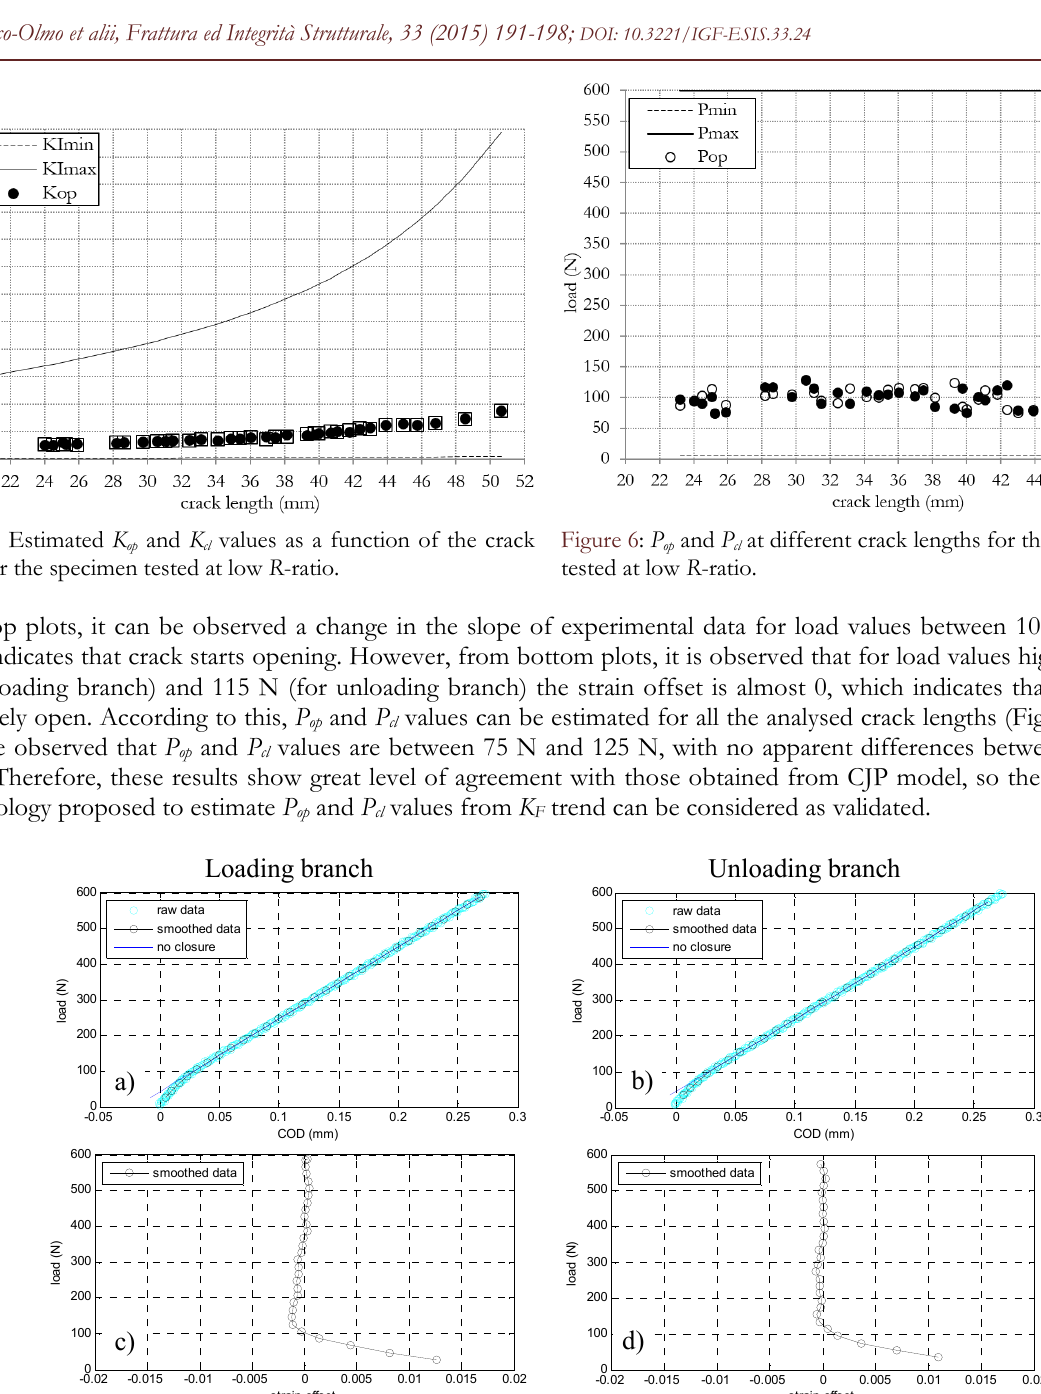
Figure 7: Results obtained from strain offset method for a crack length of 35.47 mm corresponding to the specimen tested at low R - ratio. a) Applied load versus COD for loading branch, b) applied load versus COD for unloading branch, c) applied load versus strain offset for loading branch and d) applied load versus strain offset for unloading